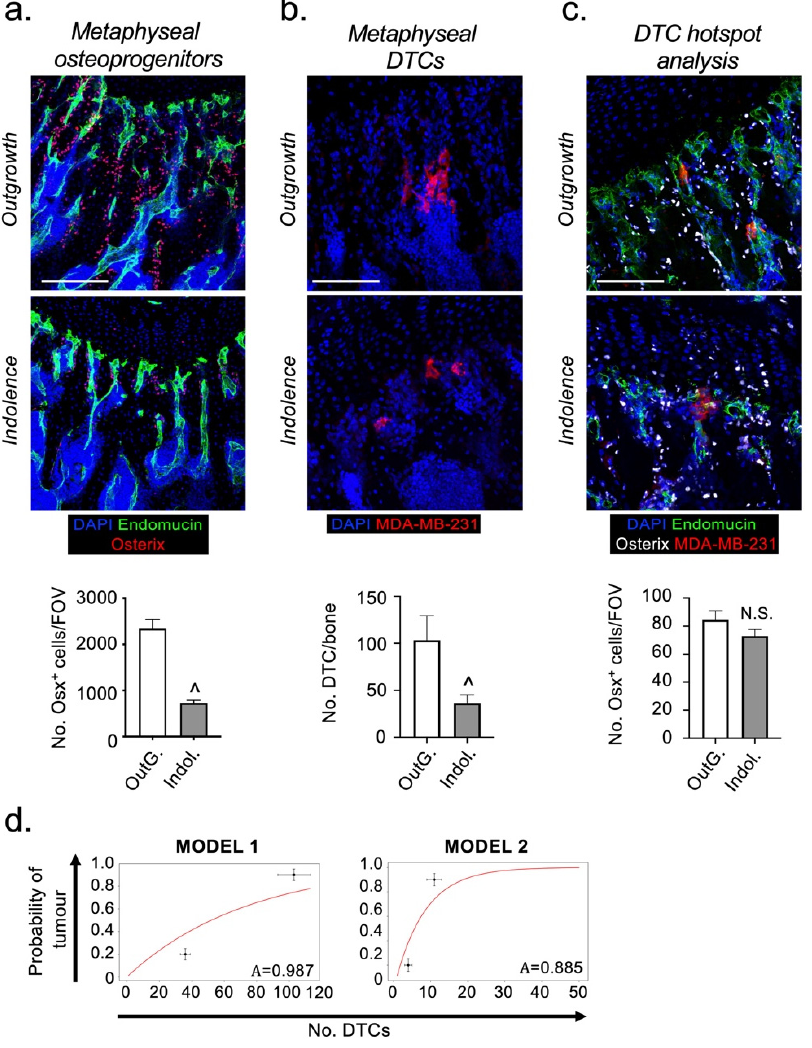
Figure 3. DTCs reside in bone microenvironments rich in osterix-expressing osteoblastic cells in both metastatic outgrowth and indolence models. ( a ) Representative immunofluorescent images and quantification of Osterix + osteoblastic cells (in red) in tibias taken from the outgrowth and